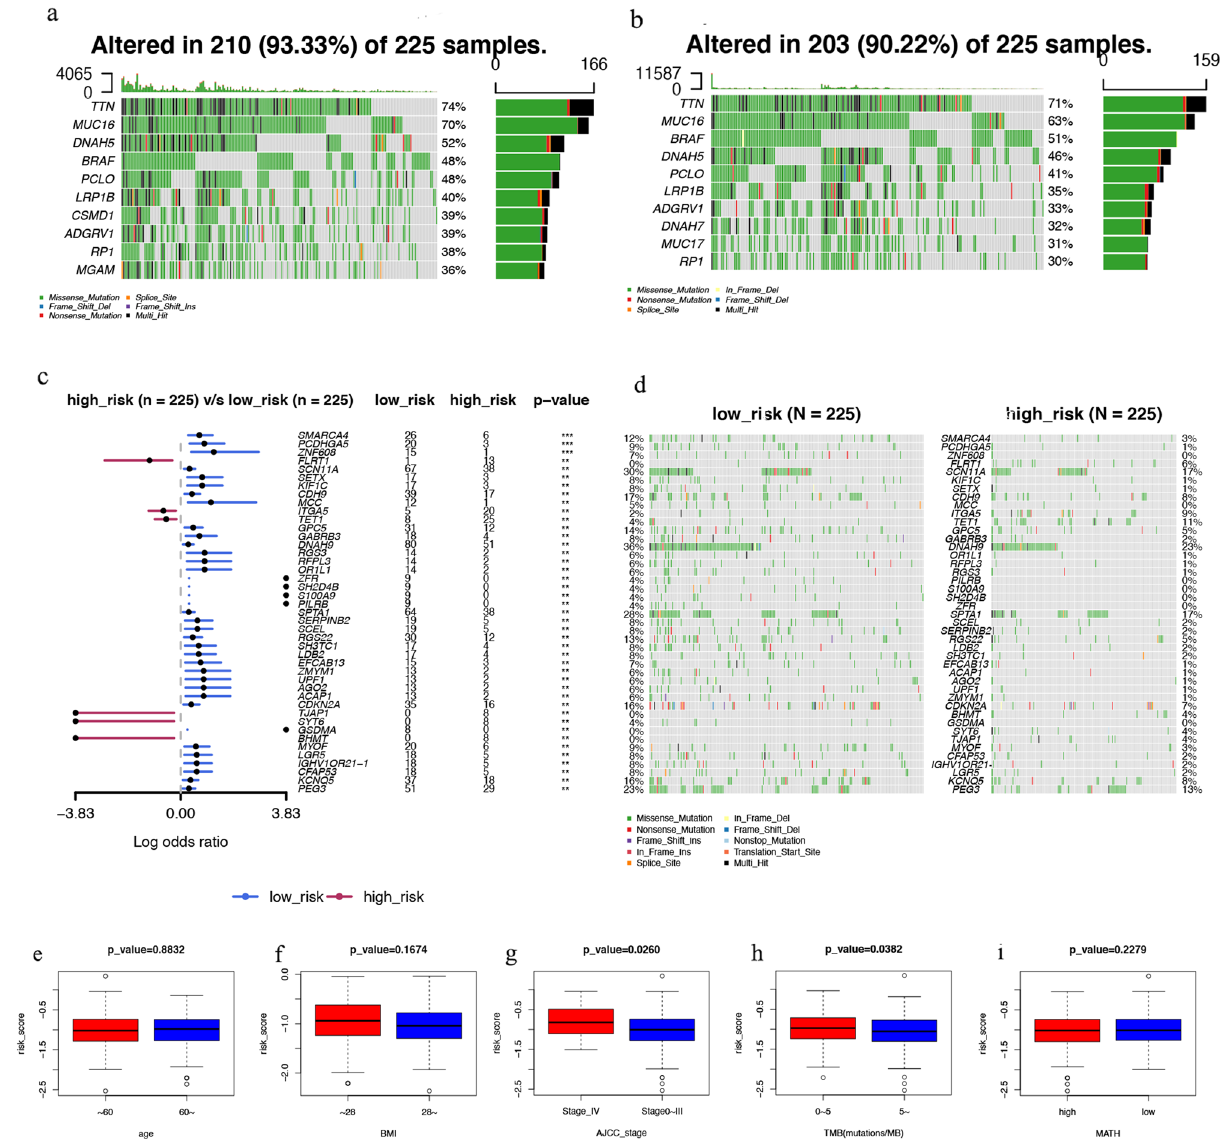
Figure 6. Association of the risk score with somatic mutations and clinicopathological factors. ( a–d ) Comparison of the frequency of somatic mutations in low- and high-risk groups. ( e–i ) Comparison of the risk score between the age, BMI, stage, TMB, and MATH subgroups. BMI body mass index, TMB tumour mutation burden, MATH mutant-allele tumour